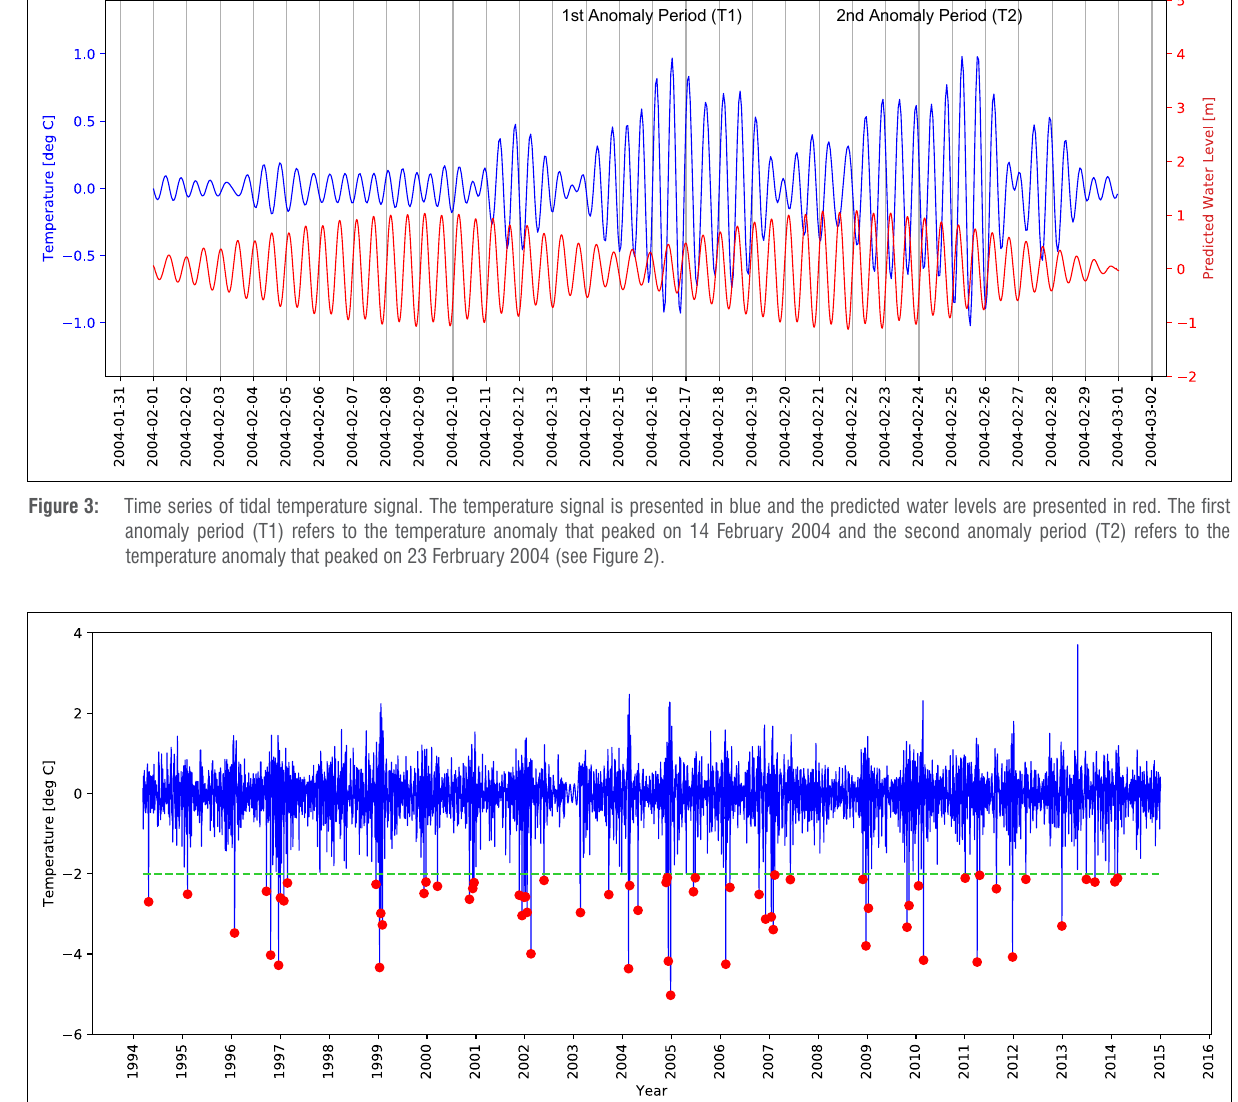
1st Anomaly Period (T1)